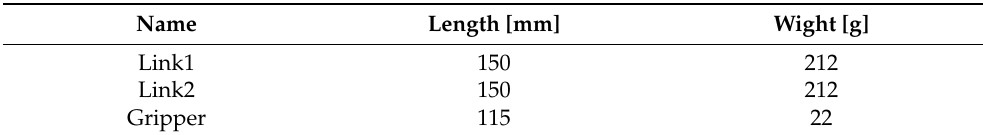
Figure 1. Robot arm configuration. ( a ) Actual robot. ( b ) simulation model. ( c ) 4 DoF representation. Table 1. Robot arm configuration.